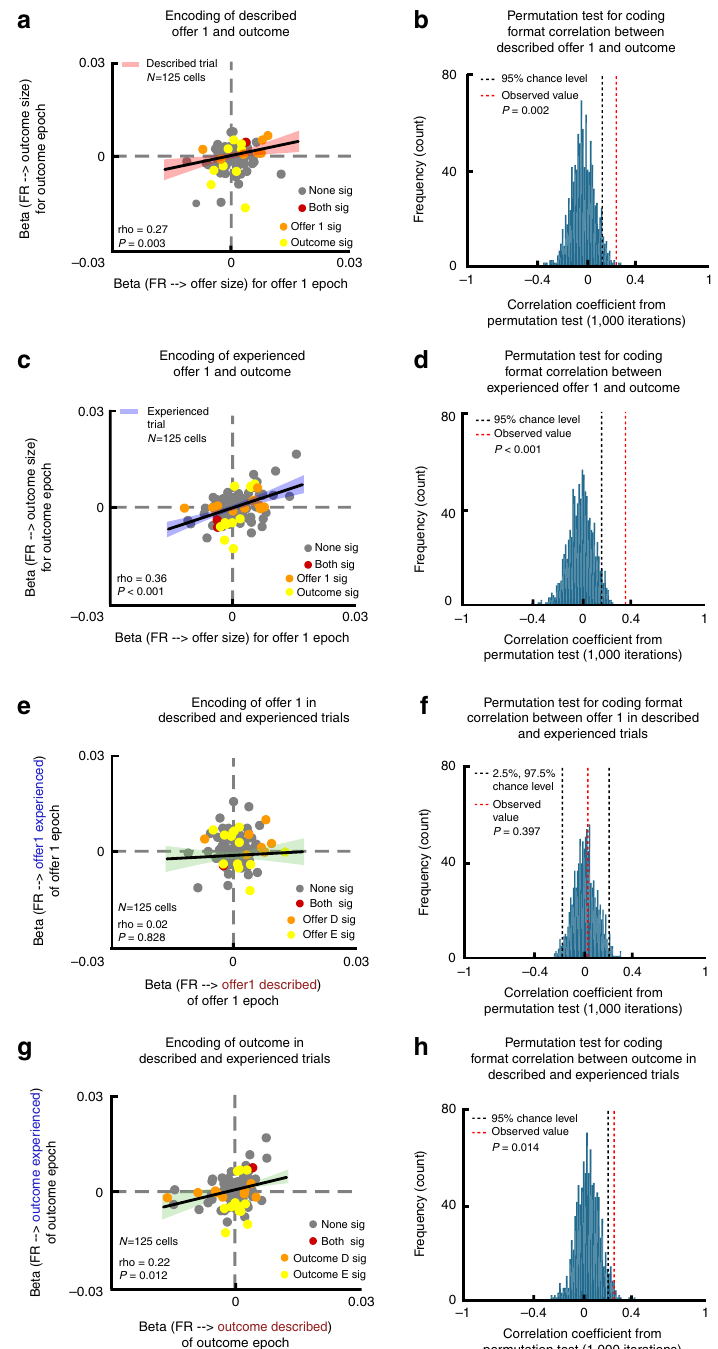
Figure 4 | Reactivation Responses. Scatter plots illustrate the correlation analyses used to assess reactivation of outcome neural response pattern during offer 1 encoding. ( a , c , e , g ) Each dot represents a neuron. Orange: the neuron is significantly tuned in the regression described on the x -axis. Yellow: the neuron is significantly tuned in the regression described on the y -axis. Red: the neuron is significantly tuned in the regressions described on both the x-axis and the y -axis. Grey: the neuron is not significantly tuned in either the regression described on the x -axis or the y -axis. ( b , d , f , h ) Permutation test of significance for the correlation coefficient between two sets of regression coefficients. ( a , b ) Reactivation for described offers: correlation between regression coefficients for offer size in offer 1 epoch ( x -axis) and outcome size in outcome epoch (y-axis). Positive correlation indicates overlapped neural response pattern. ( c , d ) Reactivation for experienced offers: correlation between regression coefficients for offer size in offer 1 epoch ( x -axis) and outcome size in outcome epoch ( y -axis). Positive correlation indicates matching neural response pattern. ( e , f ) Unrelated coding for described and experienced offers: correlation between regression coefficients for described offer in offer 1 epoch ( x -axis) and experienced offer in offer 1 epoch ( y -axis). This lack of correlation is consistent with no overlap in coding scheme for described and experienced offers. ( g , h ) Similar coding for outcomes across described and experienced trials: correlation between regression coefficients for described-trial outcome in outcome epoch ( x -axis) and experienced-trial outcome in outcome epoch ( y -axis). This significant correlation indicates a positive overlap in coding scheme for described and experienced